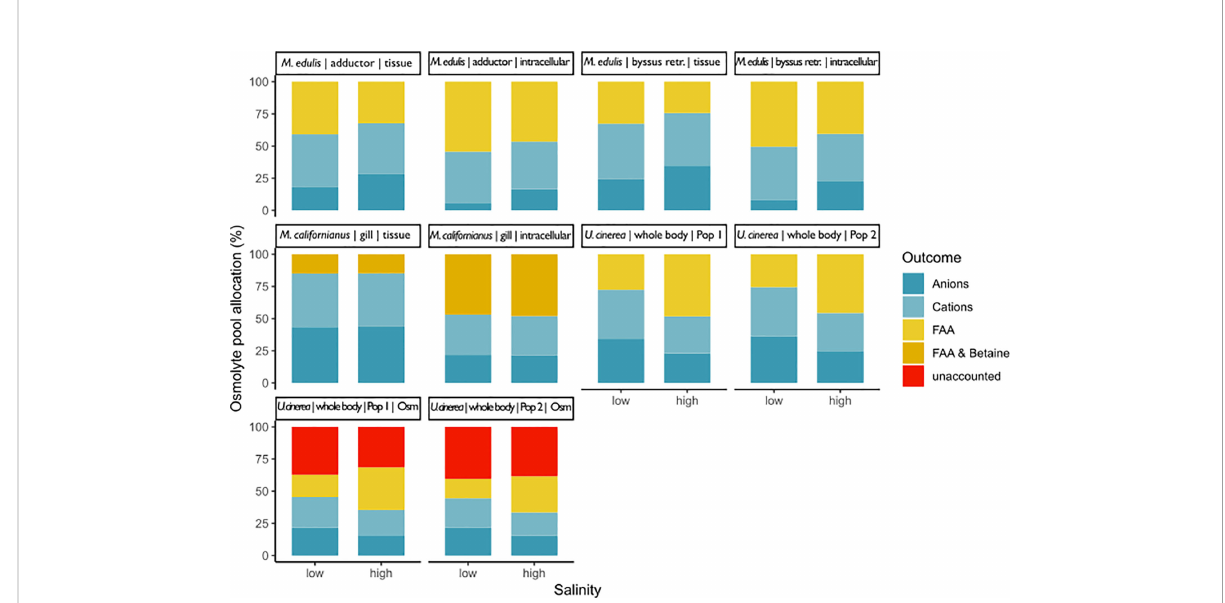
FIGURE 7 This graph shows the composition of the osmolyte pool at low and high salinity for three different bivalve and a gastropod mollusc species: Mytilus californianus gills (Silva, 1992), Mytilus edulis adductor muscle and byssus retractor (Potts, 1958), and Urosalpinx cinerea whole body samples from two different populations (Turgeon, 1973). The percentage of the total osmolyte pool is shown on the y-axis and salinity on the x- axis. Overall pool size was calculated as the sum of measured inorganic and organic pools and also total osmolality for Turgeon (1973). Potts (1958) and Silva (1992) did not measure total osmolality. Potts (1958) and Silva (1992) did account for extracellular space and thus have results for whole tissue and intracellular space. Potts (1958) and Turgeon (1973) did not account for methylamines. Silva (1992) did account for betaine but no other